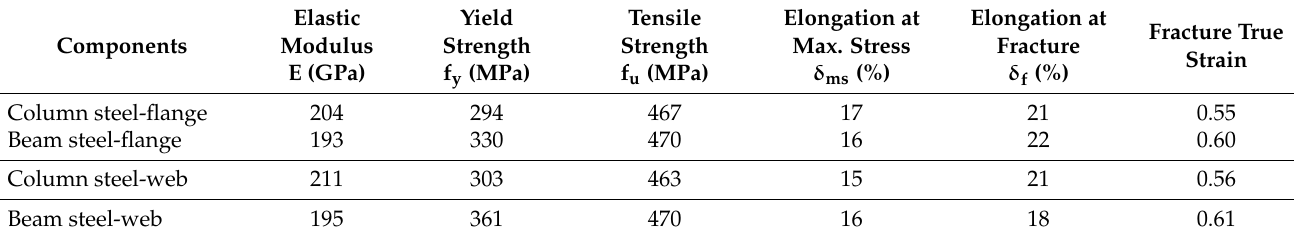
Table 3. Material properties of different components of tested specimens.